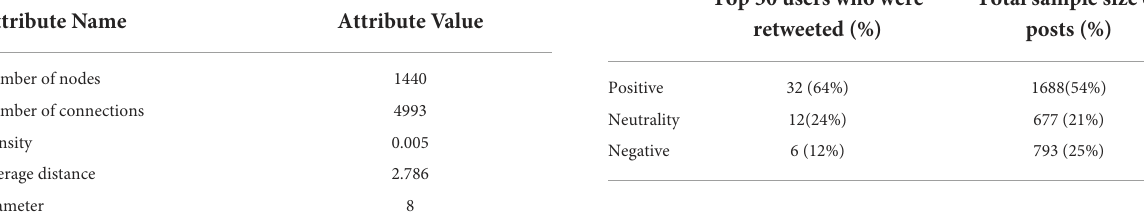
TABLE 5 Distribution of sentiment information in the